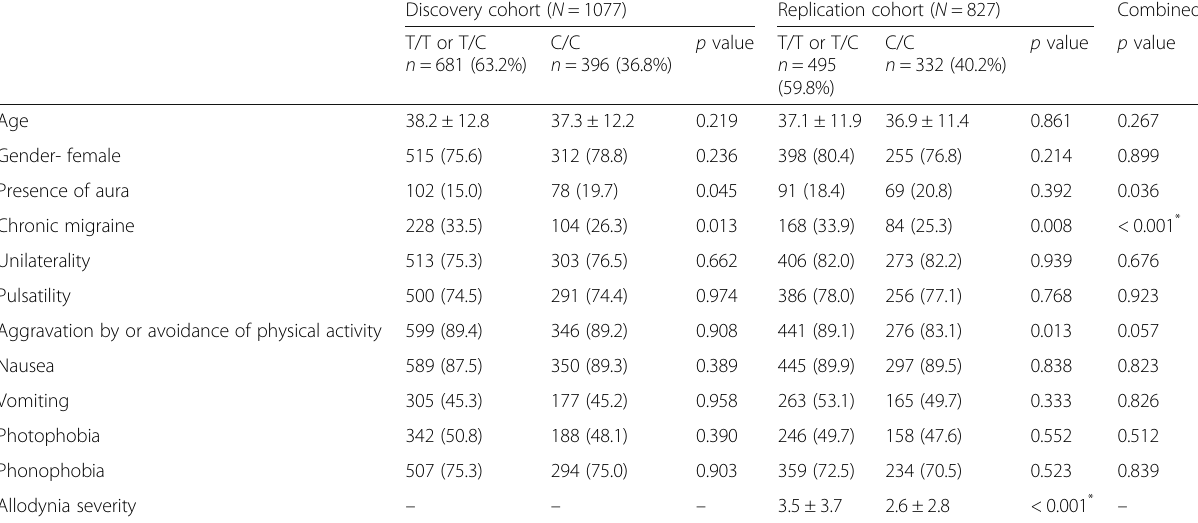
Table 2 Migraine endophenotypes and TRPM8 genotyping in